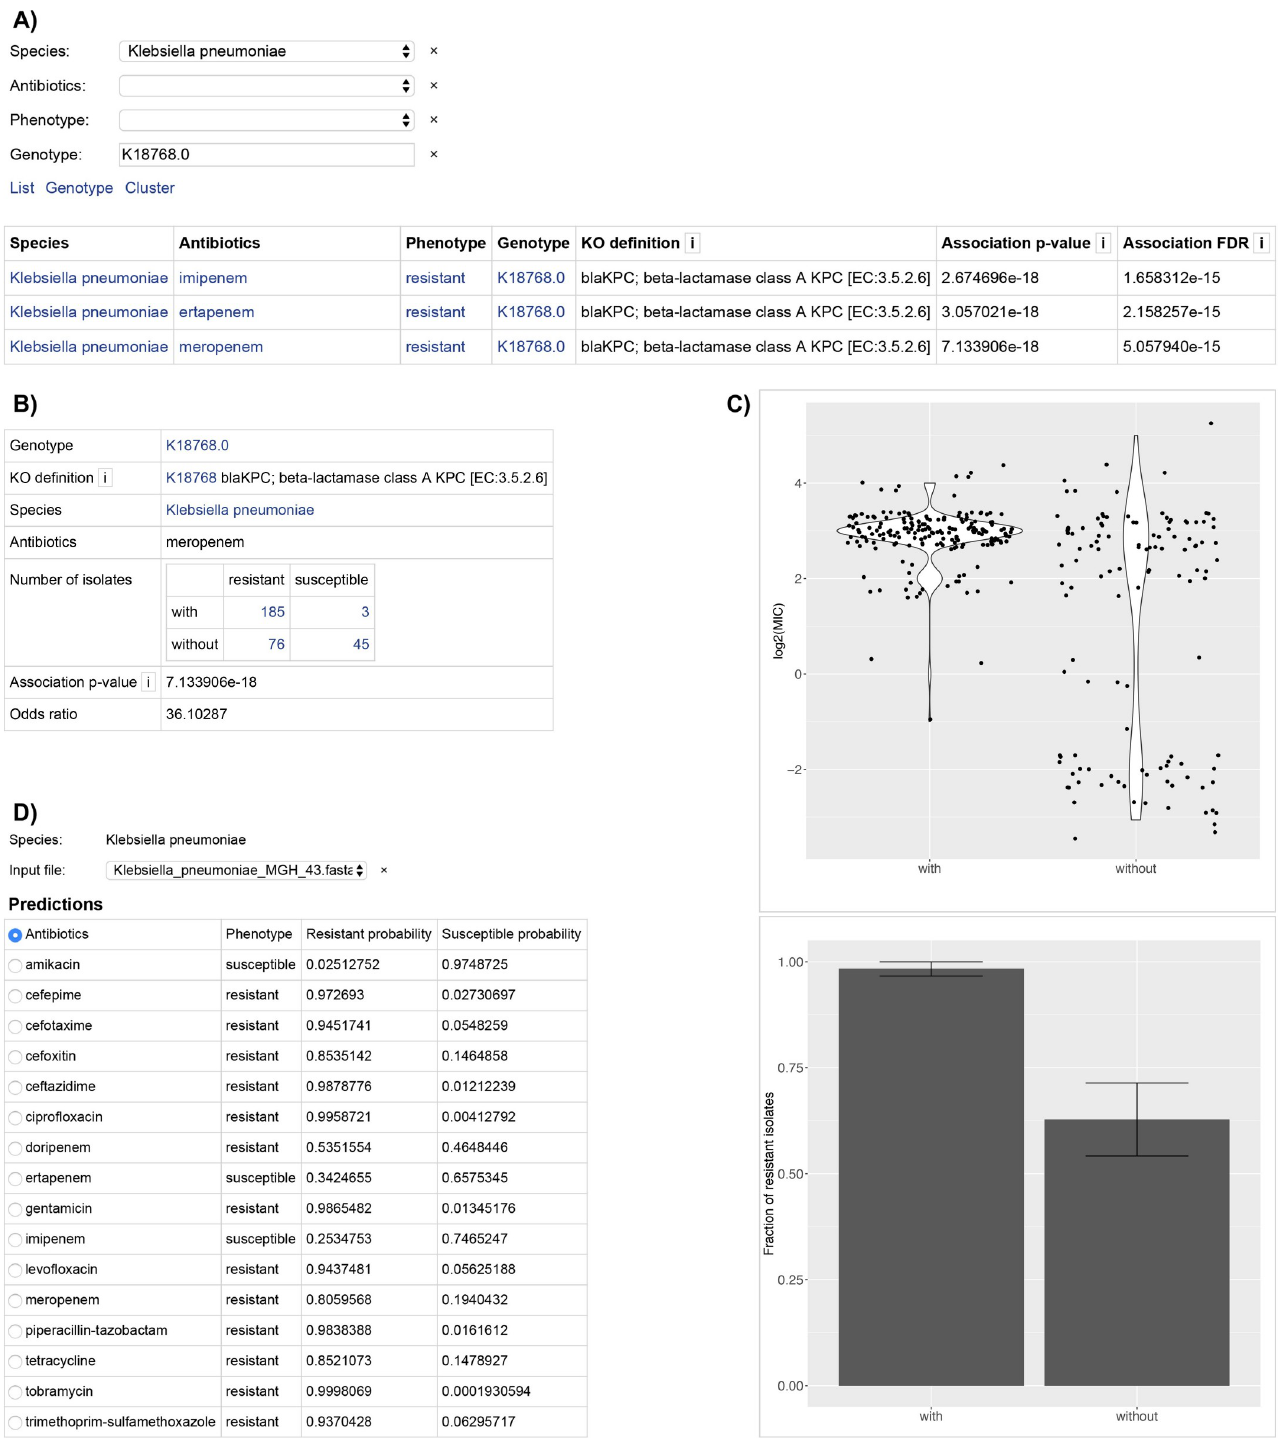
Fig 5. VAMPr provides rich sets of online resources for association models and prediction models. Users have the flexibility to explore known or novel antibiotic resistance-associated variants, and can upload their own sequence assembly and obtain predictions on antibiotic resistance. (A) association results webpage: users can explore variants, their interpretations, and their statistical significance assessments; (B) detailed information, contingency table and odd-ratio for variant K18768 in the association model, and distribution plots; (C) Distribution plots for variant K18768 in the association model page; (D) prediction models allow for uploads of users’ sequence data for antibiotic resistance